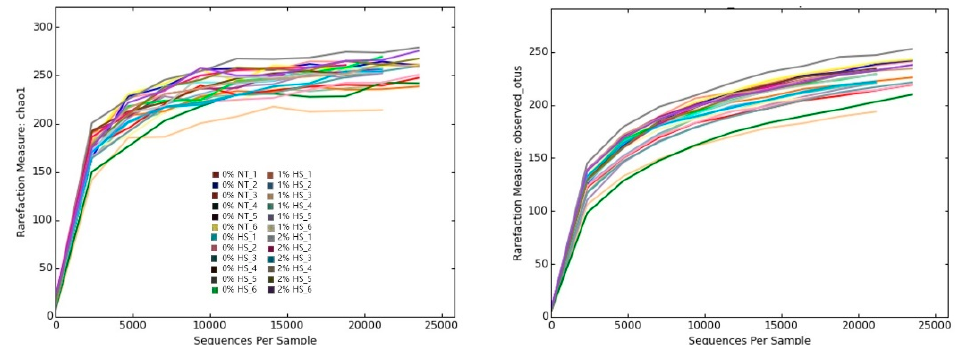
Figure 2. Rarefaction curve of Chao1 and observed OTUs for each sample. There are twenty-four samples represented by different colored lines that belong to four treatment groups of six replicates each. The treatments were control diet containing 0% steam-exploded pine particles (SPP) at thermoneutral temperature (0% NT), control diet with acute heat stress (0% HS), 1% SPP-supplemented diet at acute heat stress (1% HS), and 2% SPP-supplemented diet at acute heat stress (2% HS). The thermoneutral birds were maintained at 21.0 °C while the temperature of the heat-stressed room was raised to 31 °C within the first three hours and then maintained for another three hours that made the total HS period of six hours.